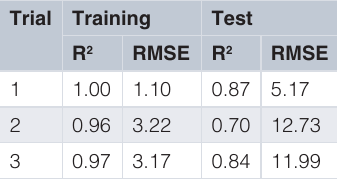
Table 2. Derivation of the support vector regression model for simulation data sets. For each trial, model performance was assessed on the basis of R 2 and root mean square error (RMSE) values for training and test data